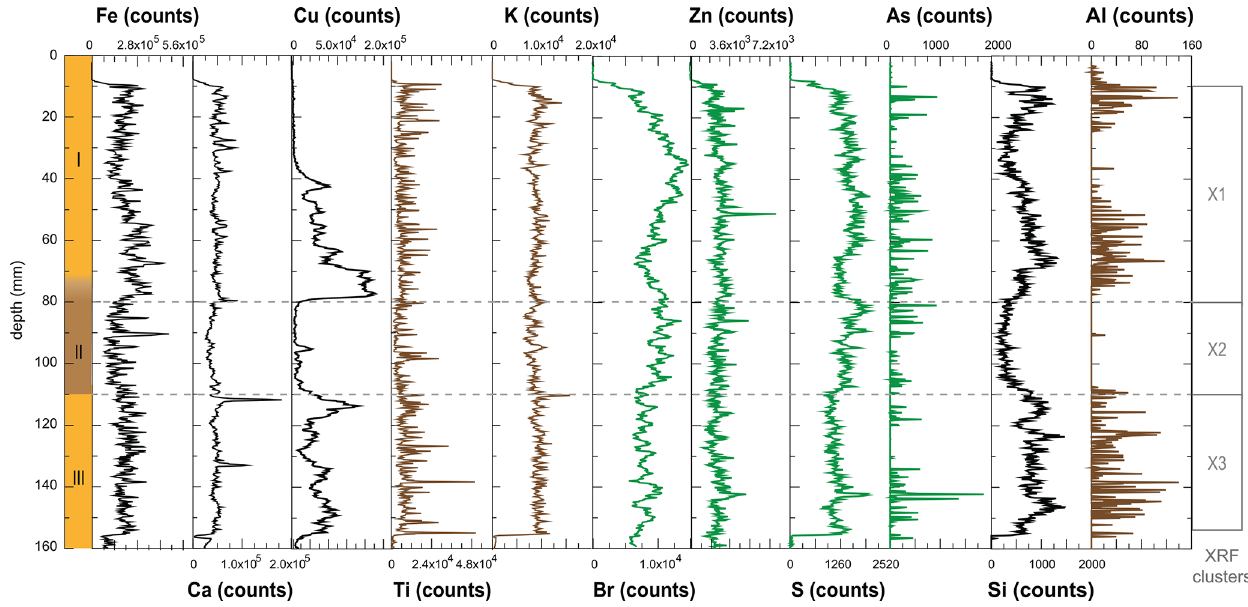
Figure A3. Element contributions to stomach-oil deposit WMM7, recorded by ITRAX XRF scanning (Croudace et al., 2006). Note that the amplitude of the signal decreases from left to right. Potential minerogenic (Ti, K, Al; brown), biogenic (Br, Zn, S, As; green), and mixed (Fe, Ca, Cu, Si; black) sources are noted. Cluster analysis was performed after removing data from 0–10 and 155–160mm where several elements record values of zero.